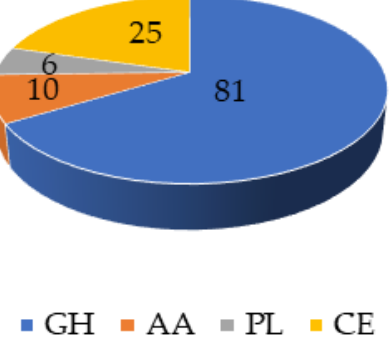
Figure 4. Distribution of secreted carbohydrate active enzymes (CAZymes) in M. fructicola genome. Enzymes were categorized as glycoside hydrolases (GH), polysaccharide lyases (PL), carbohydrate esterases (CE), and auxiliary activity (AA). Numbers in the pie chart indicate the total gene numbers in each category.